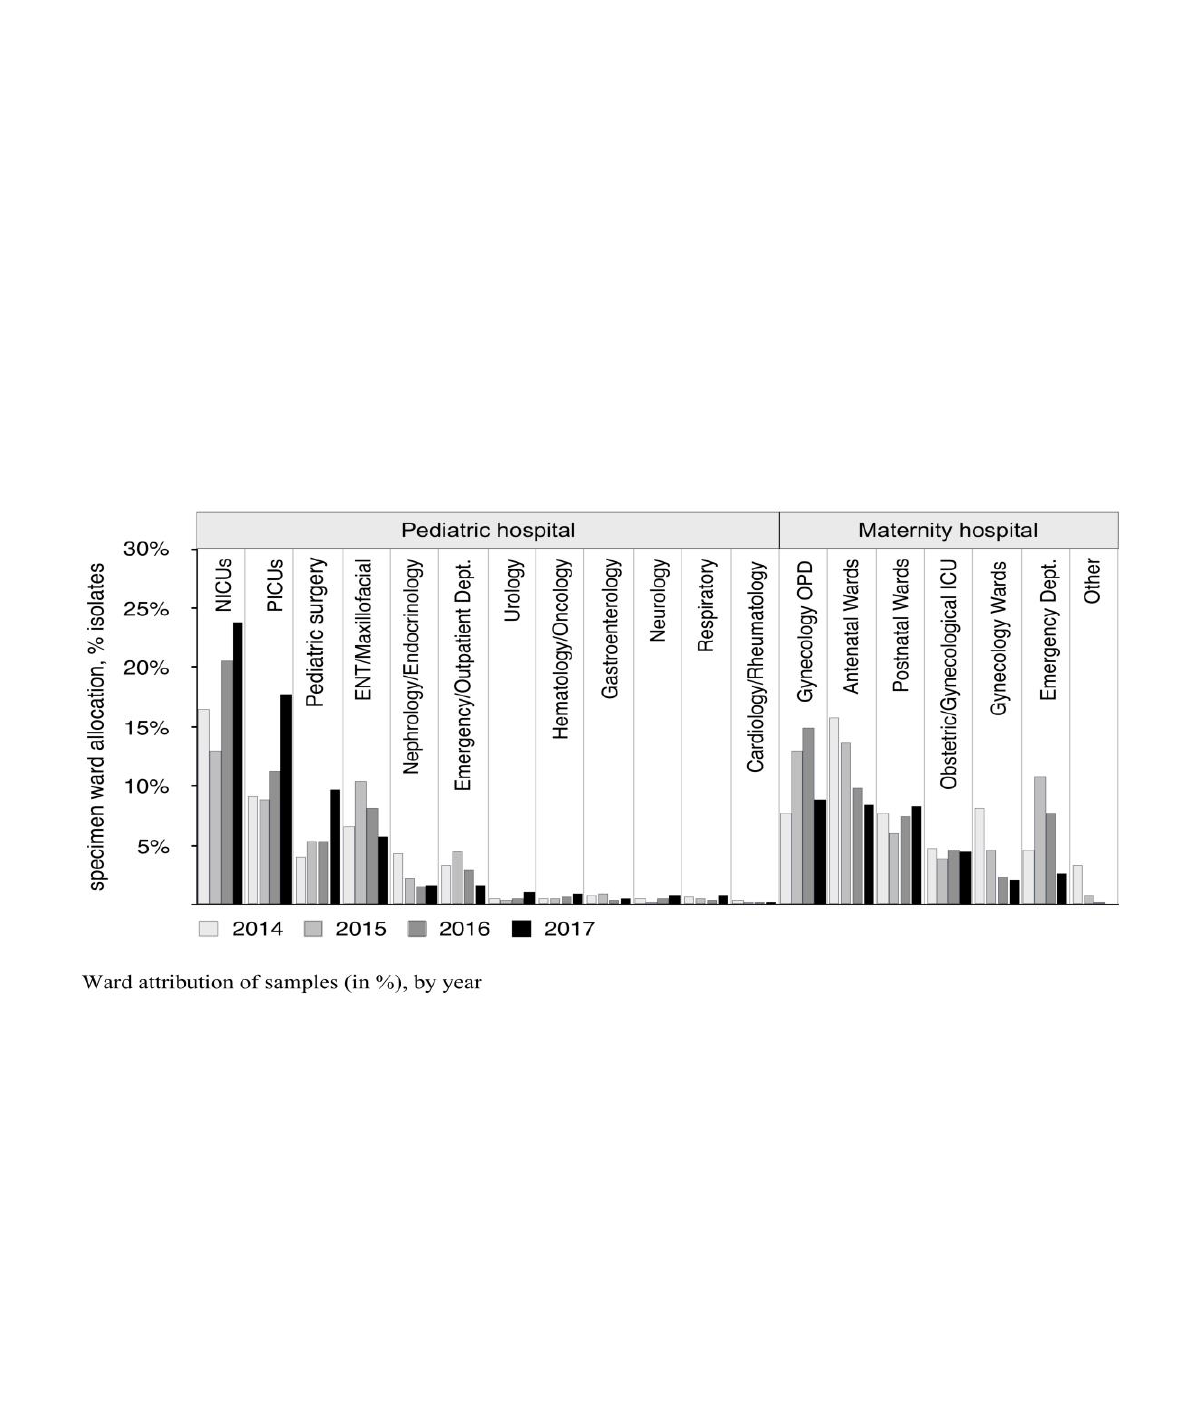
Figure 2. Ward attribution of samples (in %), by